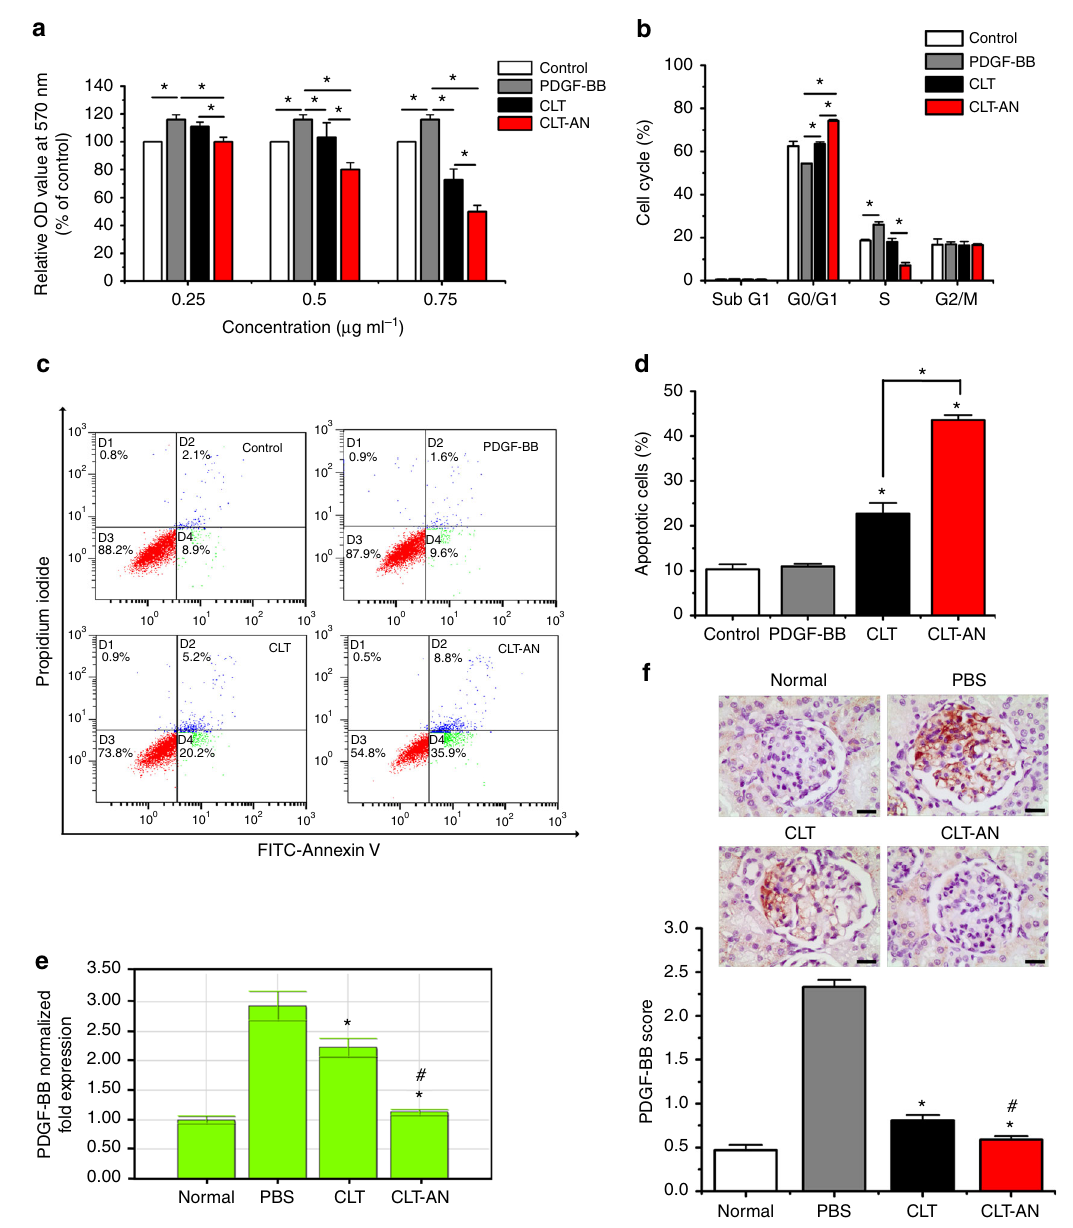
Fig. 7 Anti-proliferative effects of CLT and CLT-AN in vitro and in vivo. a Effects of CLT and CLT-AN on PDGF-BB-induced proliferation of HBZY-1 cells. b Flow cytometry analysis of the effects of CLT and CLT-AN on the cell cycle distribution of HBZY-1 cells in the presence of PDGF-BB ( C CLT = 0.25 μ g mL − 1 ). c Representative quadrant plot obtained by fl ow cytometry analysis showing the ability of CLT and CLT-AN to induce apoptosis in HBZY-1 cells in the presence of PDGF-BB. d Flow cytometry analysis of the proportions of apoptotic HBZY-1 cells after 24-h exposure to CLT or CLT-AN in the presence of PDGF-BB ( C CLT = 0.5 μ g mL − 1 ). In panels a , b , and d data are mean ± s.d. ( n = 3), results are representative of three independent experiments. * P < 0.05. Statistical signi fi cance was determined by one-way ANOVA with Tukey post hoc test. e Real-time PCR analysis of renal mRNA levels of PDGF-BB in anti-Thy1.1 nephritic rats on day 5 after treatment with CLT or CLT-AN. Data are shown as normalized fold expressions relative to normal group using β -actin mRNA as internal control. f Representative photomicrographs of immunostaining for PDGF-BB in kidney tissue sections from anti-Thy1.1 nephritic rats on day 5 after treatment with CLT or CLT-AN, and the levels of PDGF-BB were semiquantitatively scored as described in Methods on the basis of immunochemical results. Scale bars , 20 μ m. In panels e , f data are mean ± s.d. ( n = 5), results are representative of two independent experiments. * P < 0.05 vs. PBS group; # P < 0.05 vs. CLT group. Statistical signi fi cance was determined by one-way ANOVA with Tukey post hoc test Anti-in fl ammatory mechanisms of CLT and CLT-AN . Previous Taken together, CLT-AN with an optimal size of 95-nm selectively accumulated at mesangial cells thus forming a studies have demonstrated the monocyte chemoattractant reservoir to display sustained therapeutic effects. CLT-AN protein-1 (MCP-1) and intercellular adhesion molecule-1 showed better capacity than CLT in reducing proteinuria, (ICAM-1) secreted by mesangial cells are two well-known con- ameliorating the acute and progressive glomerular lesions in tributors to the recruitment of monocytes into glomeruli 35, 36 . These in fi ltrating cells further produce proin fl ammatory anti-Thy1.1 nephritic rats through anti-in fl ammatory, cytokines such as interleukin-6 (IL-6) and interleukin-1 β (IL-1 β ), anti-proliferative, and anti- fi brotic effects. NATURE COMMUNICATIONS | 8: